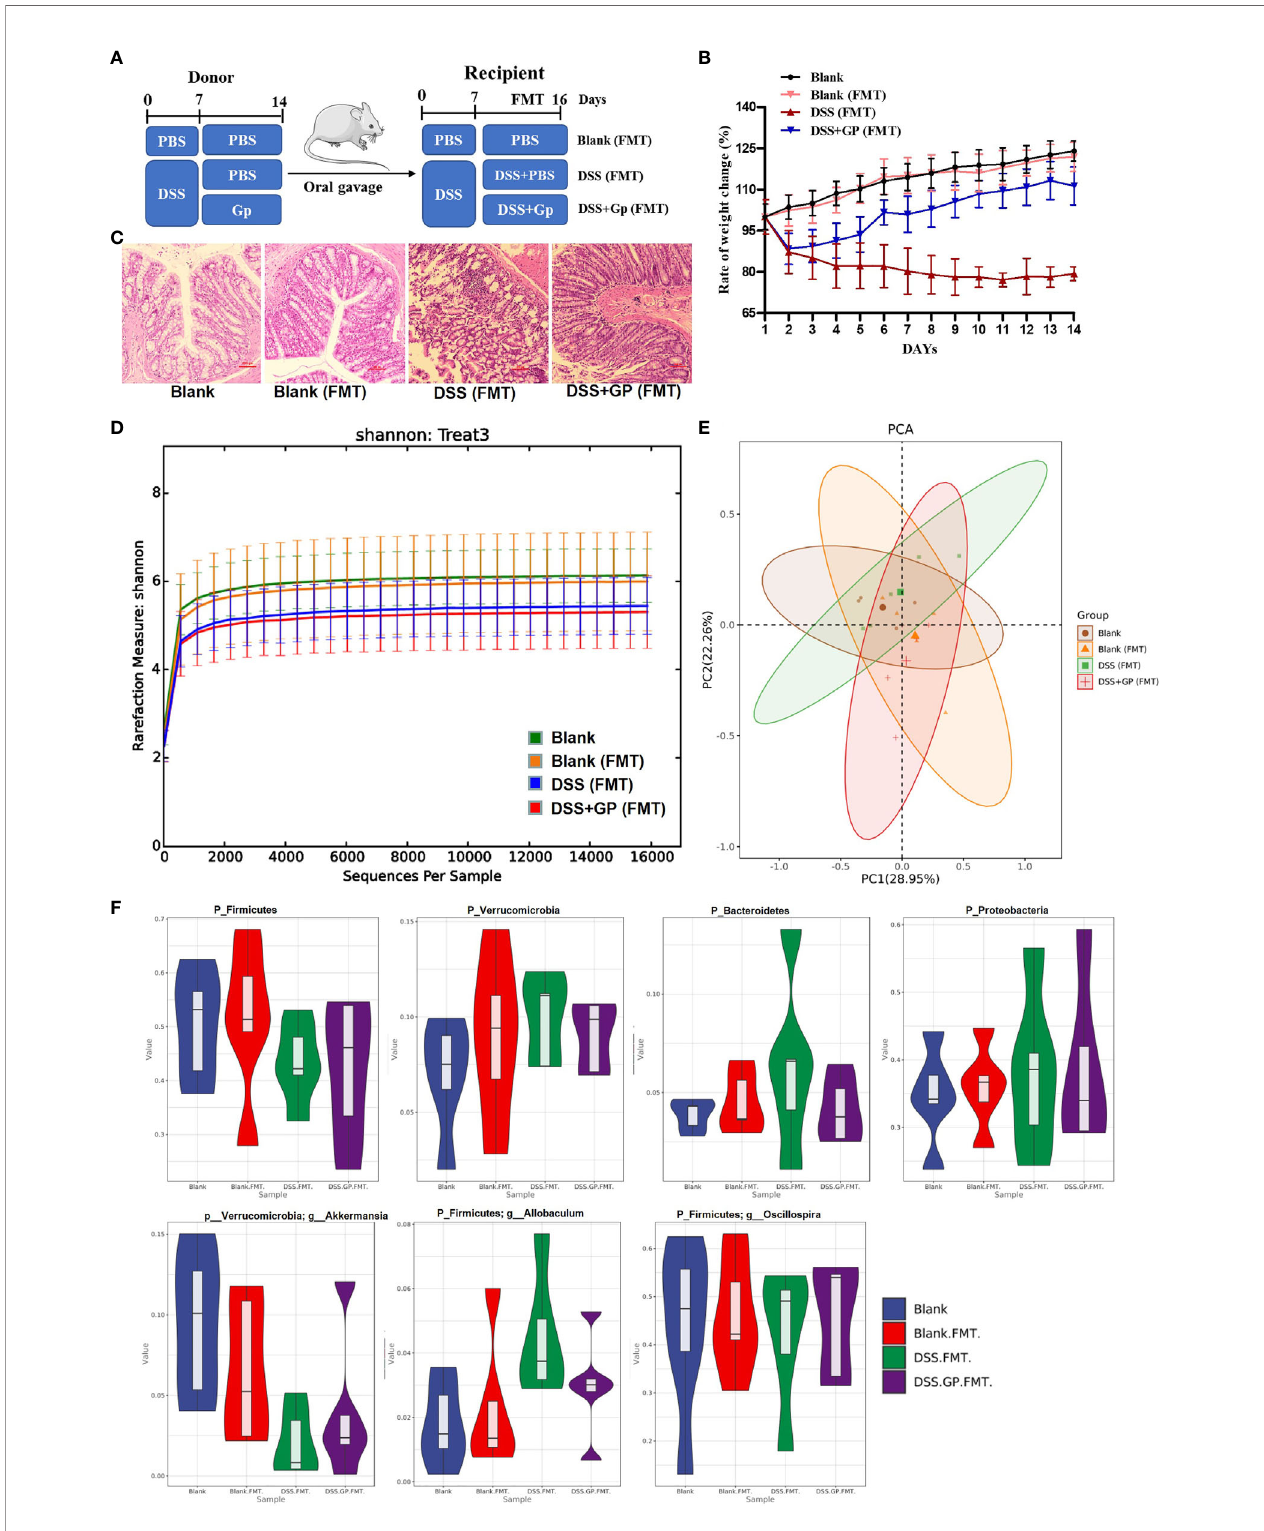
FIGURE 6 | Transplanting of fecal microbiome intervened by GP improves intestinal in fl ammation. (A) The experimental protocol for FMT. (B) Changes of body weight (n=10). (C) Histopathological changes after HE staining. (D) Rarefaction curves of OUT quantity. (E) PCA analysis. (F) The gut microbiota composition among experimental groups at phylum/genus